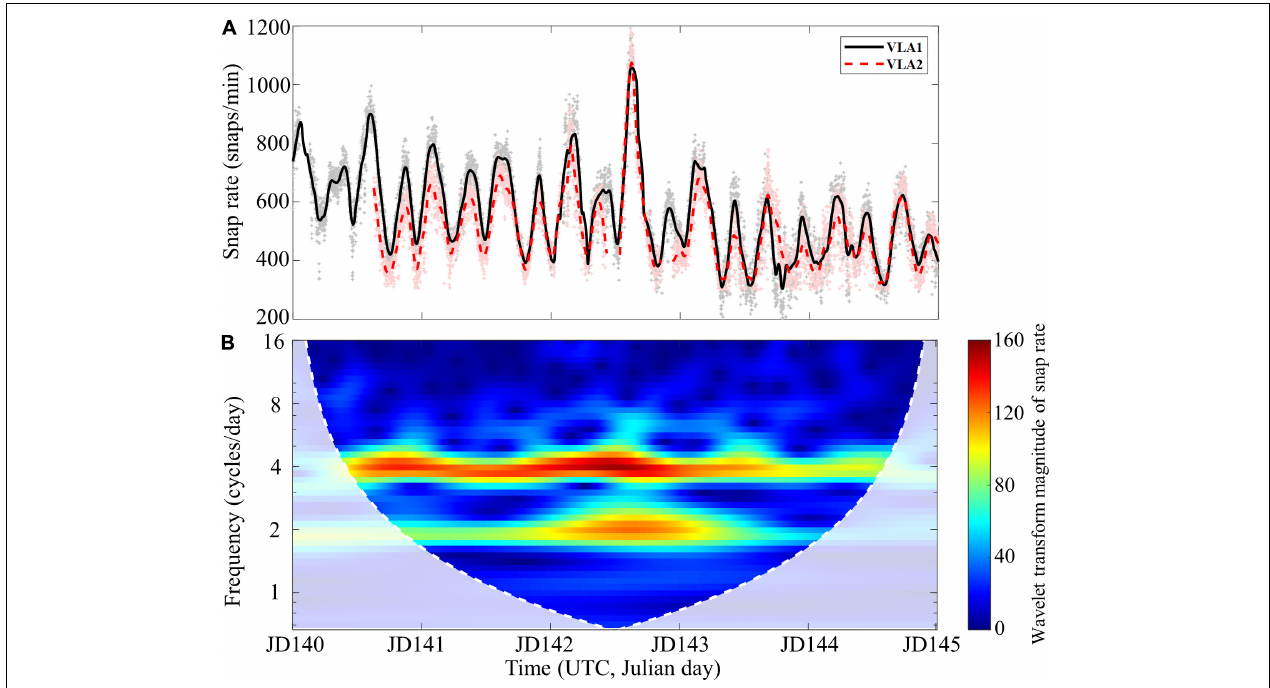
FIGURE 6 | (A) Temporal variation of the snap rate extracted from the bottommost hydrophones of VLA1 (solid, gray dots) and VLA2 (dashed, pink dots) over a 5-day period (JD 140–JD 145). Each dot represents the snap rate calculated per minute, and a 90-point moving average produces the two smooth lines. Although the two arrays are separated by 5.5 km, the patterns are strikingly similar. (B) Magnitude scalogram of the snap rate at the VLA1 using the Morse wavelet method. The white dashed line marks the boundary of the cone of influence, and the shaded region below the line is affected by edge-effect artifacts. The scalogram highlights that the one-quarter-diurnal (four cycles per day) period is dominant in the snapping noise generated by the snapping shrimp inhabiting the SAVEX-15